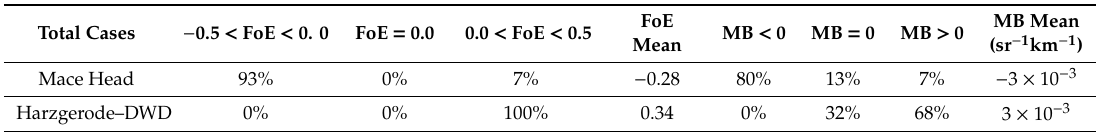
Table 5. Percentage of occurrence of di ff erent factor of exceedance (FoE) and MB values considering the total number of cloud–free cases at Mace Head and